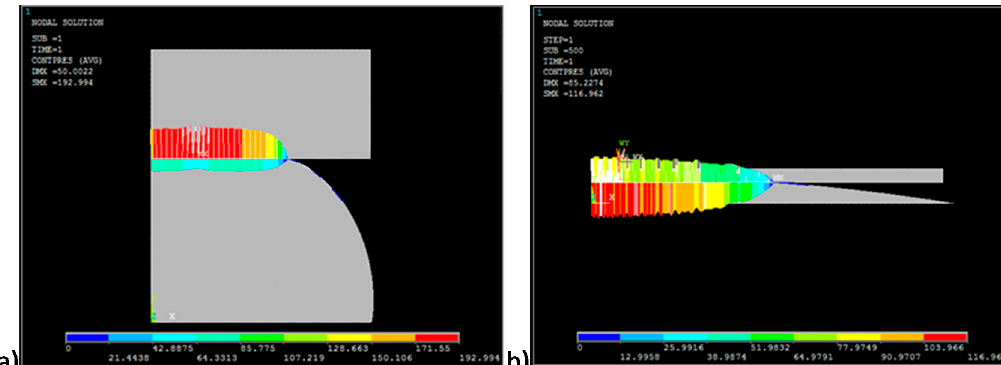
Figure 24. Exemplary distribution of contact pressures between the face of the rigid cylinder and the polyoxymethylene: ( a ) Hemisphere; ( b ) Spherical cap.